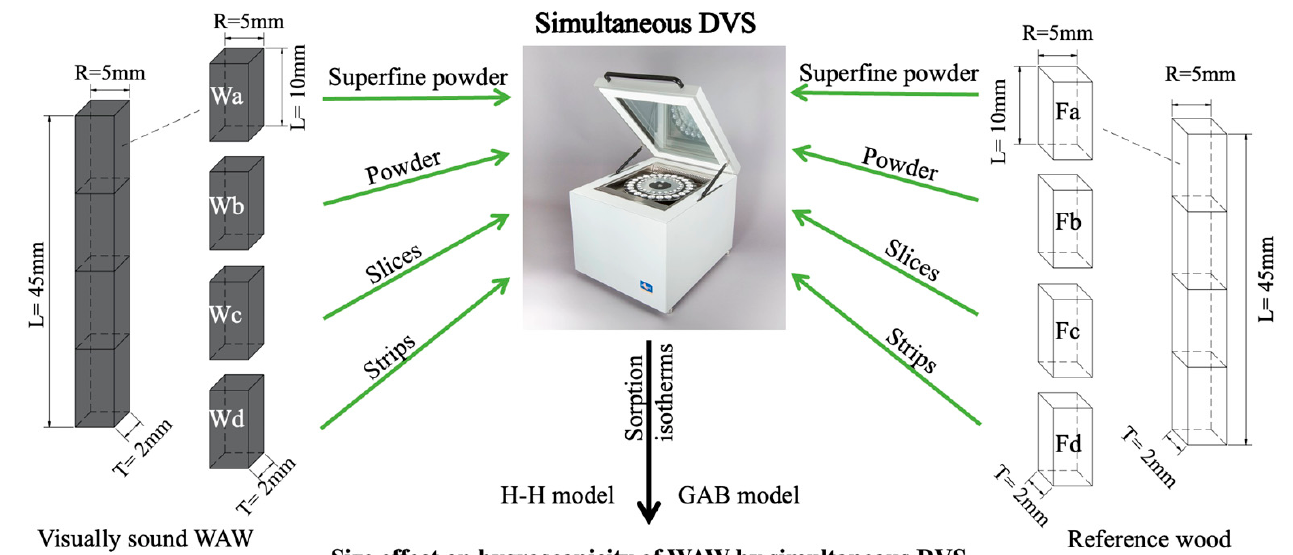
Figure 1. Scheme for the preparation and the testing of the DVS samples.